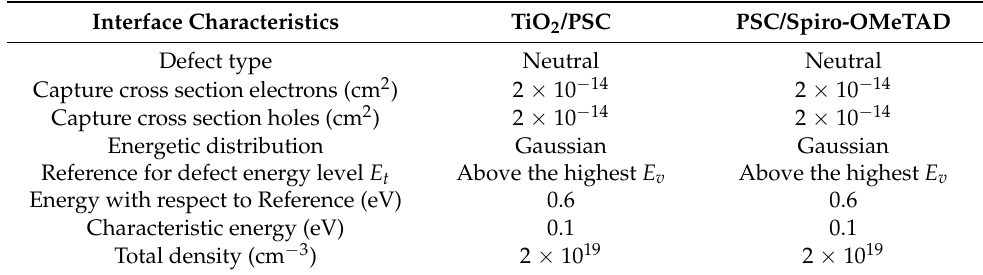
Table 2. Interface characteristics